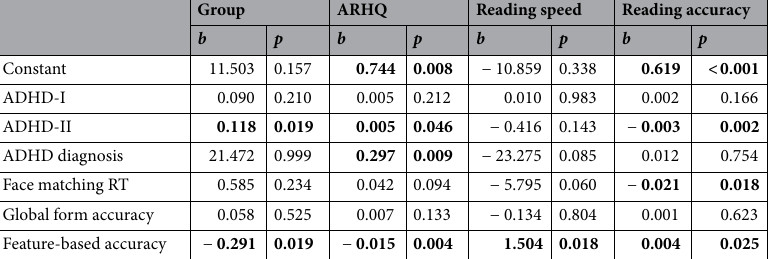
Table 1. Summary of regression models with group membership (logistic regression, χ R 2 Nagelkerke = 0.560), ARHQ (linear regression, F (6,53) = 6.831, p < 0.001, R 2 = 0.436, R 2 adjusted = 0.372), reading speed (linear regression, F (6,53) = 2.400, p = 0.040, R 2 = 0.462, R 2 adjusted = 0.214) and reading accuracy (linear regression, F (6,53) = 3.145, p = 0.010, R 2 = 0.263, R 2 adjusted = 0.179) as dependent variables, and measures of ADHD and face processing as independent variables. Unstandardized regression coefficients ( b) and p -values are bold for significant independent